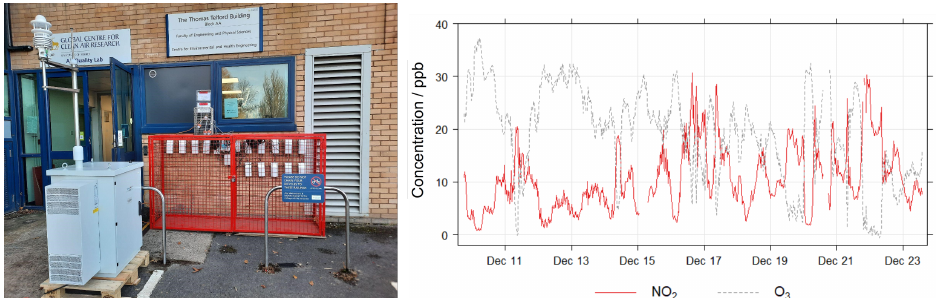
Figure 10. EC Field calibration and validation setup ( left ), and pollutant time-series ( right